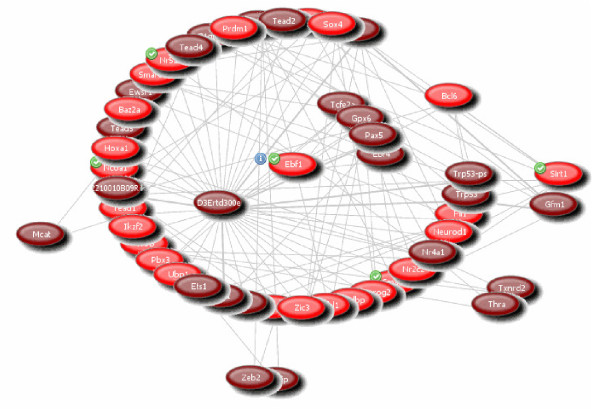
Network showing the interconnections between 1q miRNA targets belonging to GO category "SP_PIR_Transcription Regulation genes" (colored in red) and their first order literature neighbours (colored in brown). The connectivity of putative miRNA targets was analysed using the literature co-citation network PubGene (http://www.pubgene.org), see Materials and Methods.